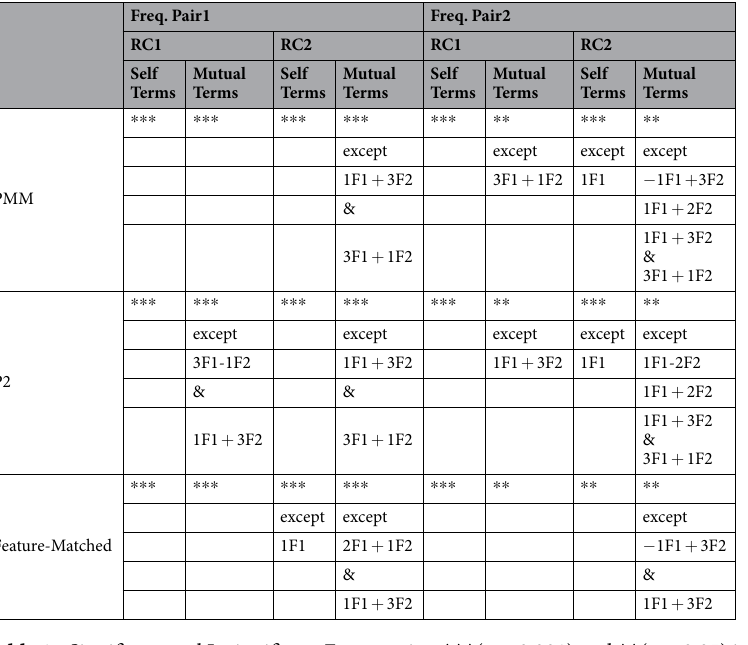
Table 1. Significant and Insignificant Frequencies. *** (p < 0.001) and ** (p < 0.05) indicate that for all frequencies the Hotelling’s t 2 test showed that the real and imaginary components of the response were significantly different from [0, 0]. The frequencies indicated in the tables are the ones which were not significant.